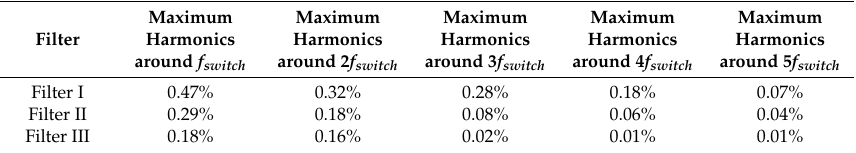
Table 6. Maximum harmonic magnitude as percentage of fundamental with the three filters. Maximum Maximum Maximum Maximum Maximum Harmonics Harmonics Harmonics Harmonics Filter Harmonics around 2 f switch around 3 f switch around 4 f switch around 5 f switch around f switch Filter I